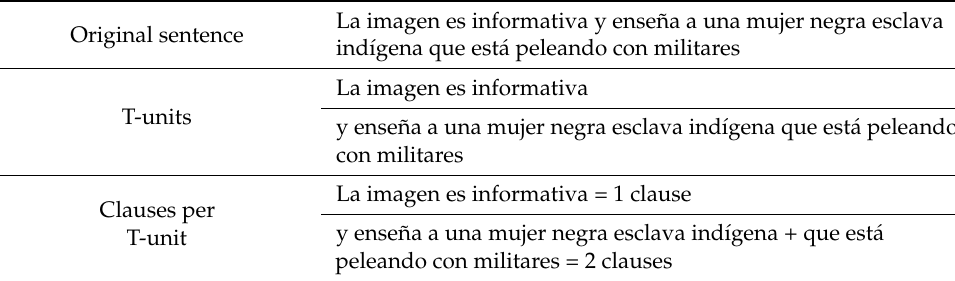
Table 1. Sample calculation for syntactic